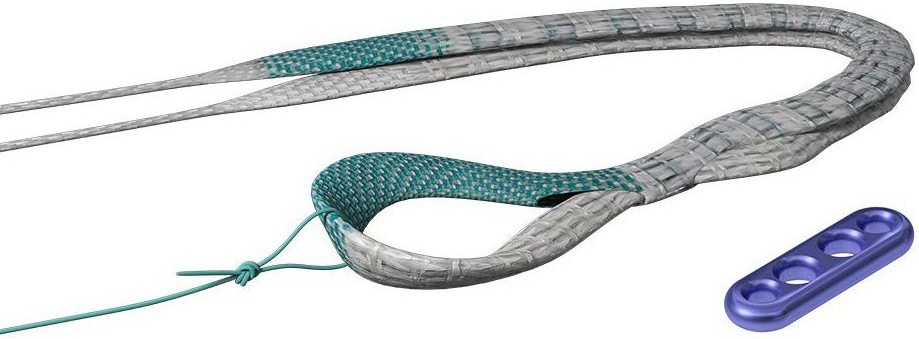
Figure 1. The Infinity-Lock Button System (Neoligaments, Leeds, UK).